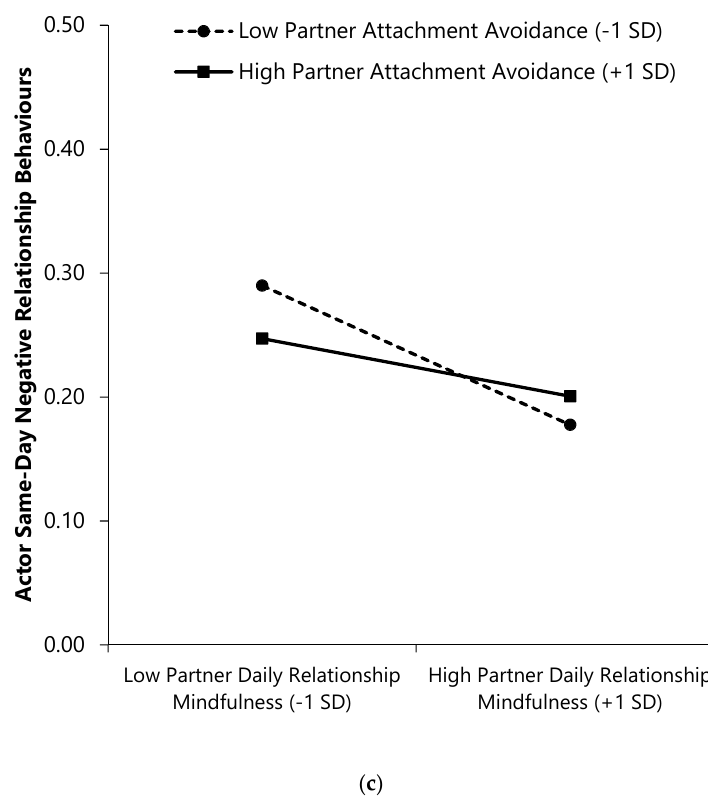
Figure 3. Interactions of attachment avoidance and daily relationship mindfulness with same-day negative relationship behaviours. ( a ) Actor × Actor interaction; ( b ) Actor × Partner interaction; ( c ) Partner × Partner interaction. Higher scores on continuous variables represent greater standing on the variable (e.g., higher daily RM).